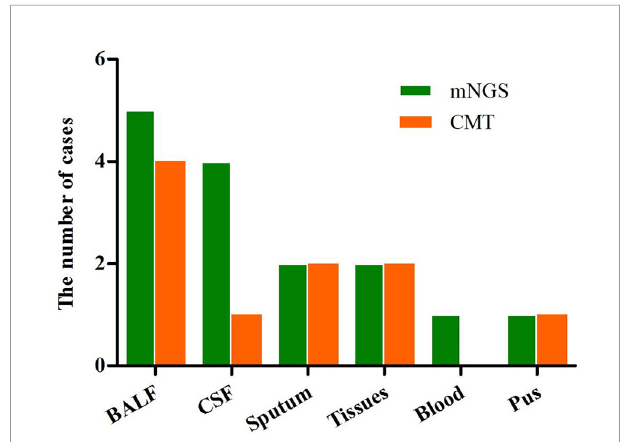
FIGURE 4 | Overall sensitivity of mNGS and CMT in the different sample